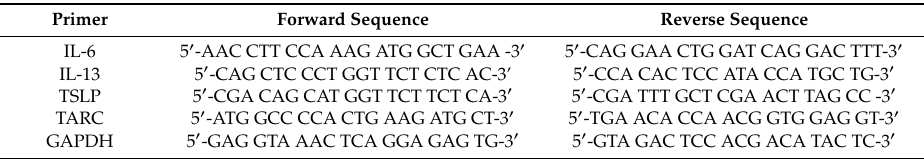
Table 4. Primers for PCR amplification.